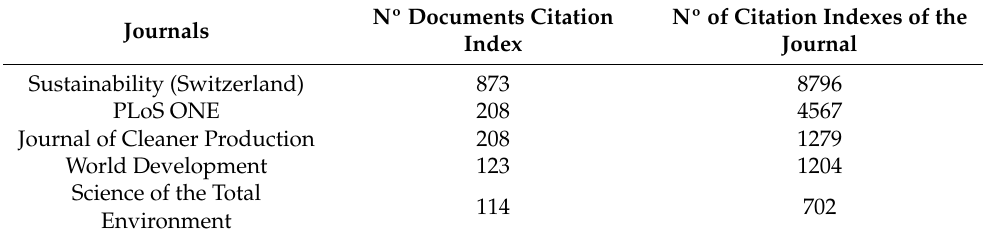
Table 3. Main journal contributing to the research